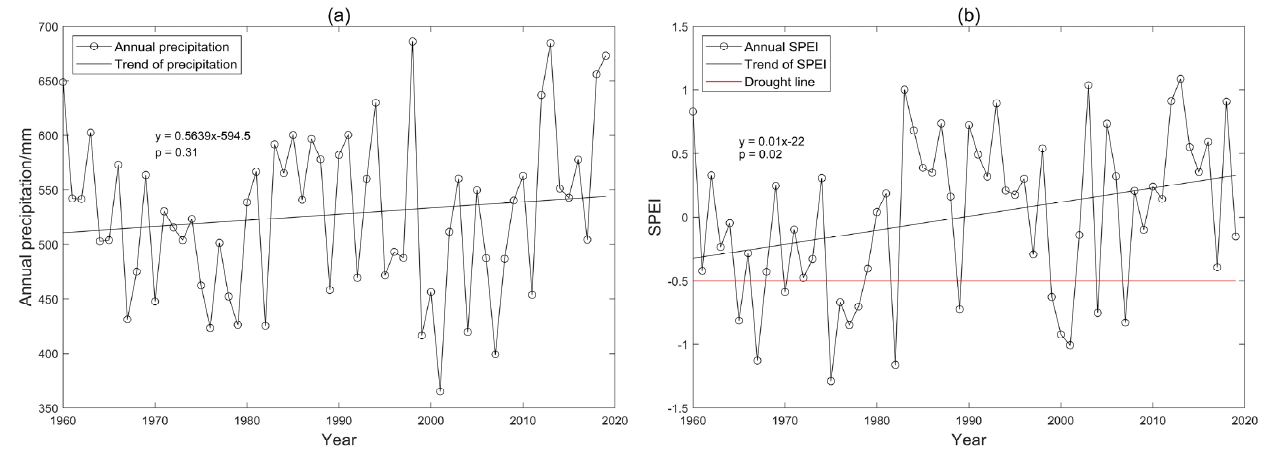
Figure 2. Annual precipitation ( a ) and SPEI ( b ) within the SHRB from 1960 to 2019. Table 2. Statistics of the Z-value of the MMK test for precipitation and SPEI on yearly and seasonal scales. Z-Value Time Period Precipitation SPEI